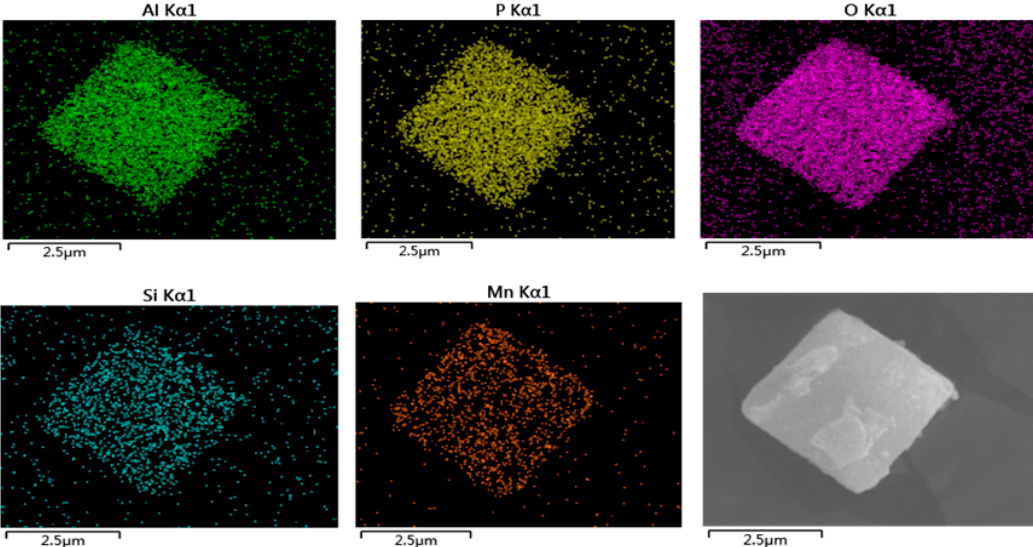
Figure 3. EDS mapping of MnO x /H-SAPO-34-0.1 catalyst.